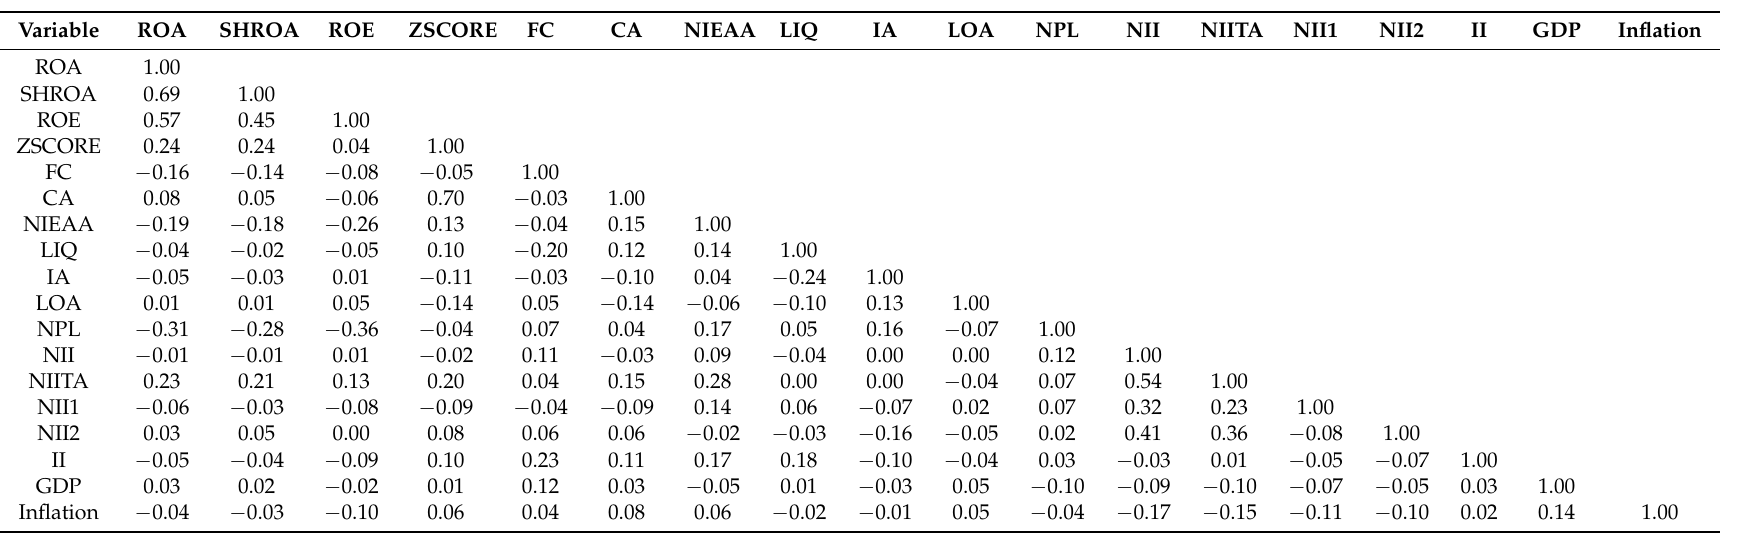
Table 3. Correlation